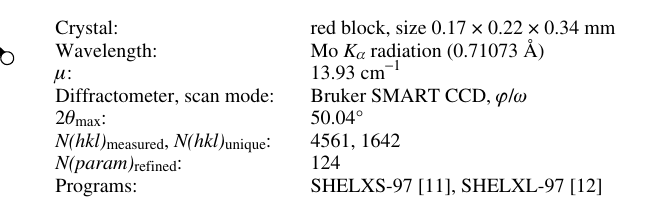
Table 1. Data collection and handling.